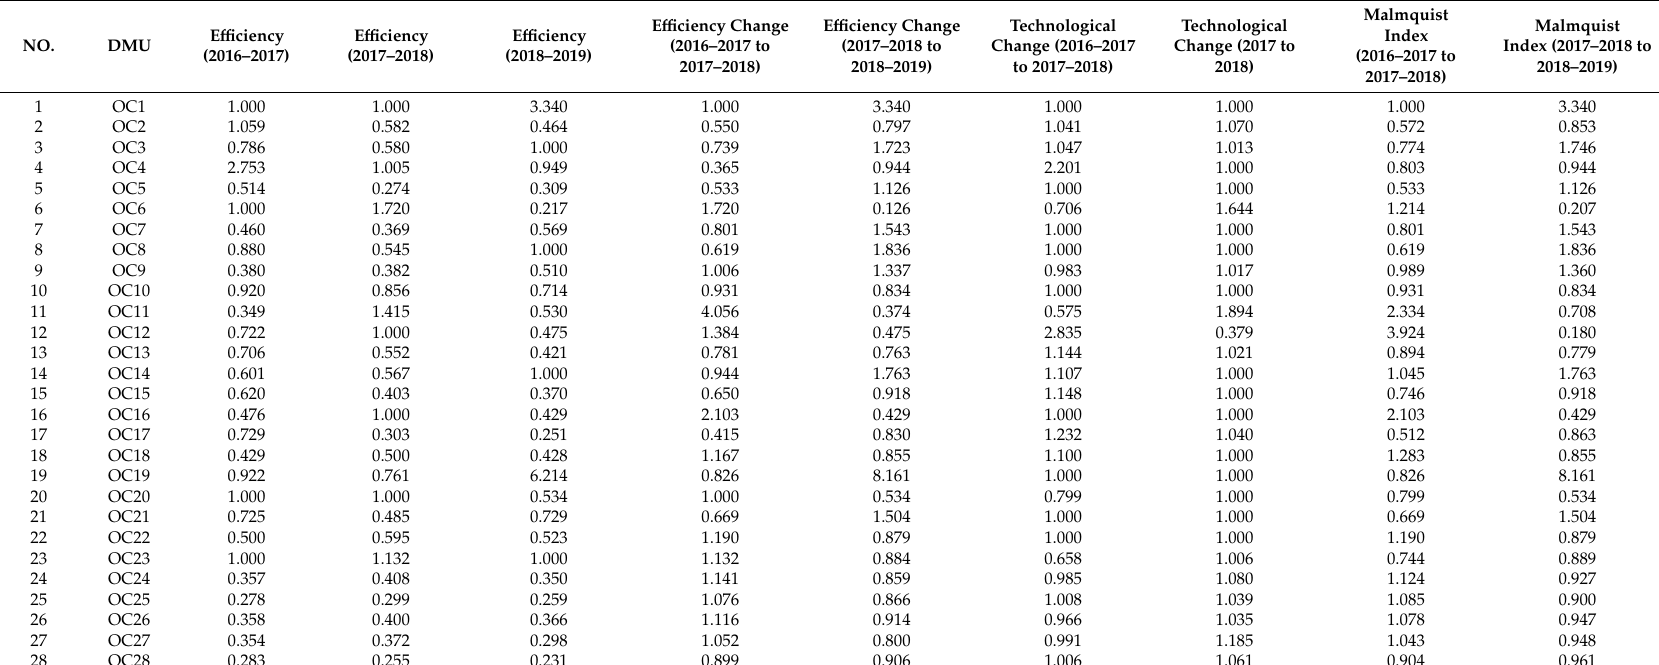
Table 3. The Malmquist Productivity Index (MPI) result of opencast